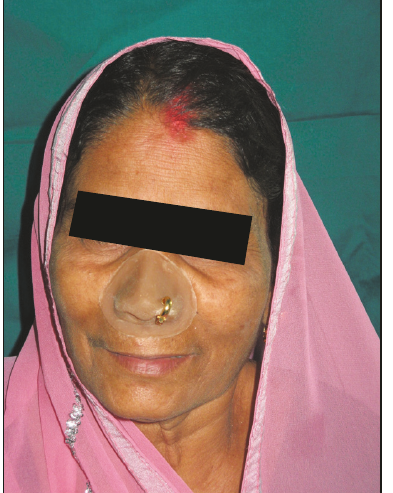
Figure 7: Definitive nasal prosthesis on patient.